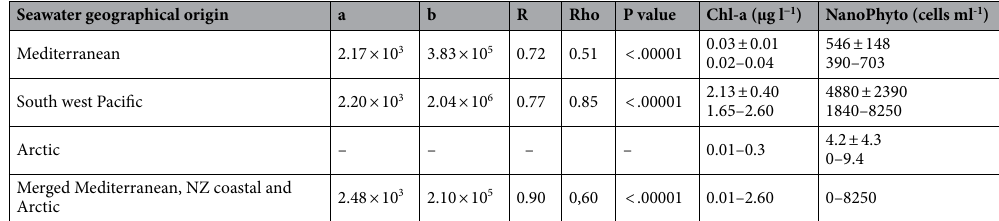
Table 1. Fitting parameters (a and b) and correlation coefficients (Pearson R) for the linear relationship between the production flux of SSA100 (F SSA100 , m −2 s −1 ) and eukaryotic nanophytoplankton cell abundance (NanoPhyto, in cells ml -1 ) in the form of F SSA100 = a * NanoPhyto + b for a wind speed of 9 m s -1 and temperature of 15 °C. The correlation coefficient Spearman Rho between these two variables is also indicated. Average, standard deviation and range (10–90 percentiles) of Chl- a and NanoPhyto for the three measurement campaigns.